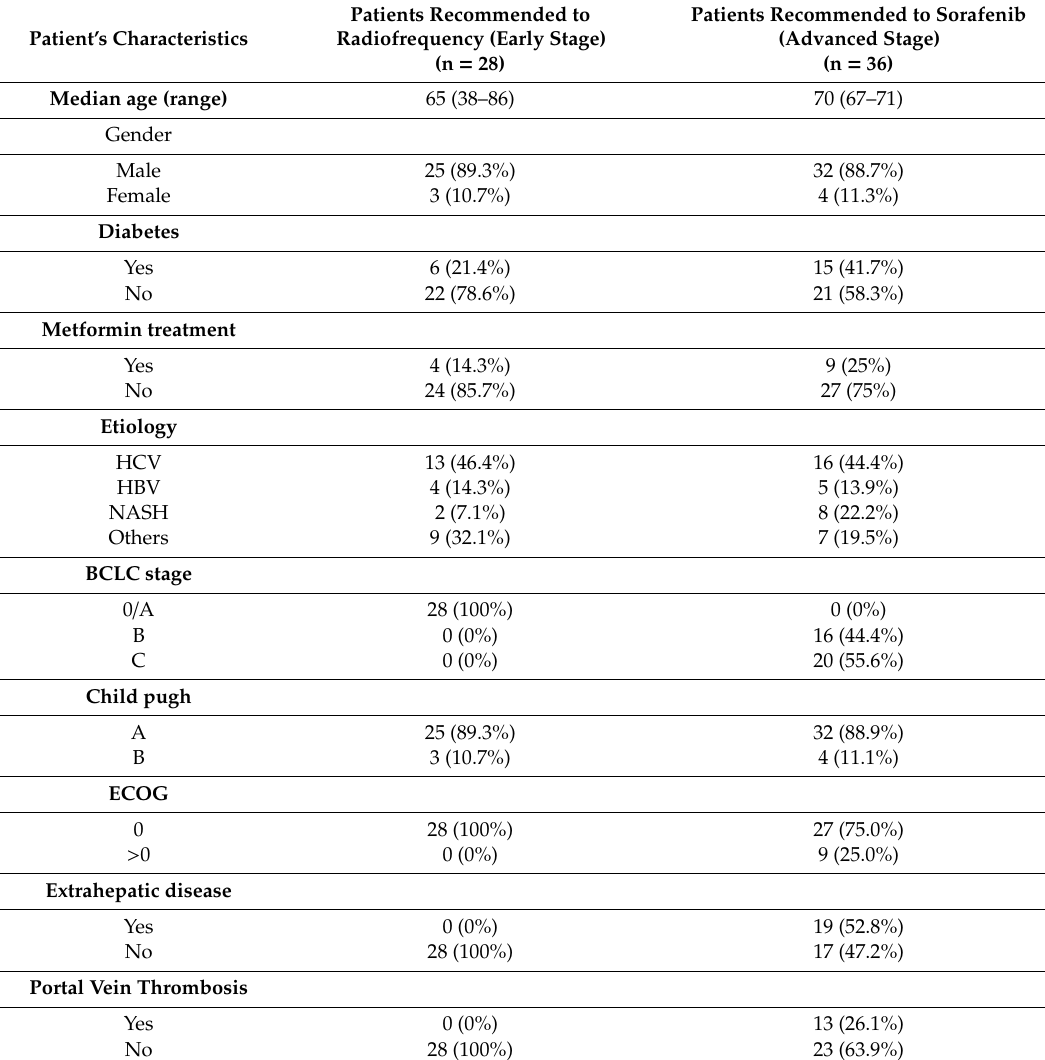
Table 1. Patient’s characteristics and